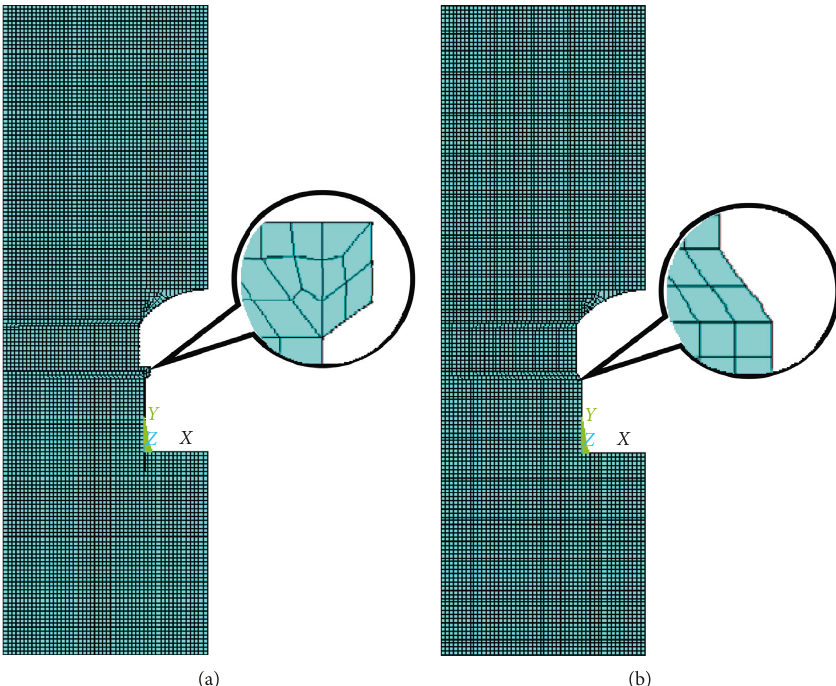
Figure 11: Schematic diagram of different morphological characteristics of the rock anchor beam in the numerical model of the un- derground powerhouse. The model of the rock anchor beam (a) after casting and (b) before casting.